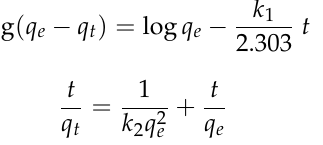
Table 2. The relevant parameters for pseudo first order adsorption and pseudo second order adsorption. Initial Concentration of Hg(II) (mg·L − 1 )